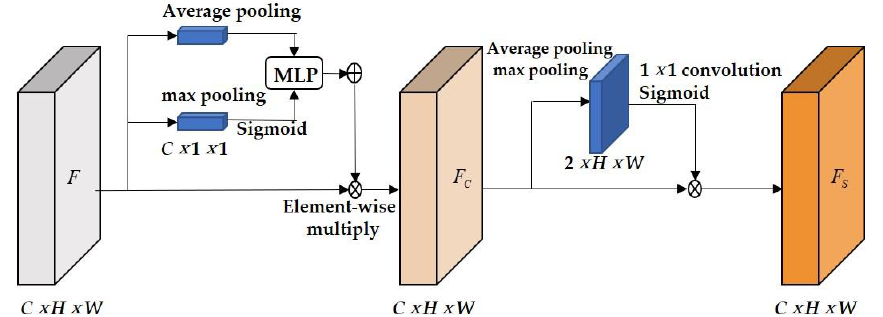
Figure 4. CBAM attention module implementation process.